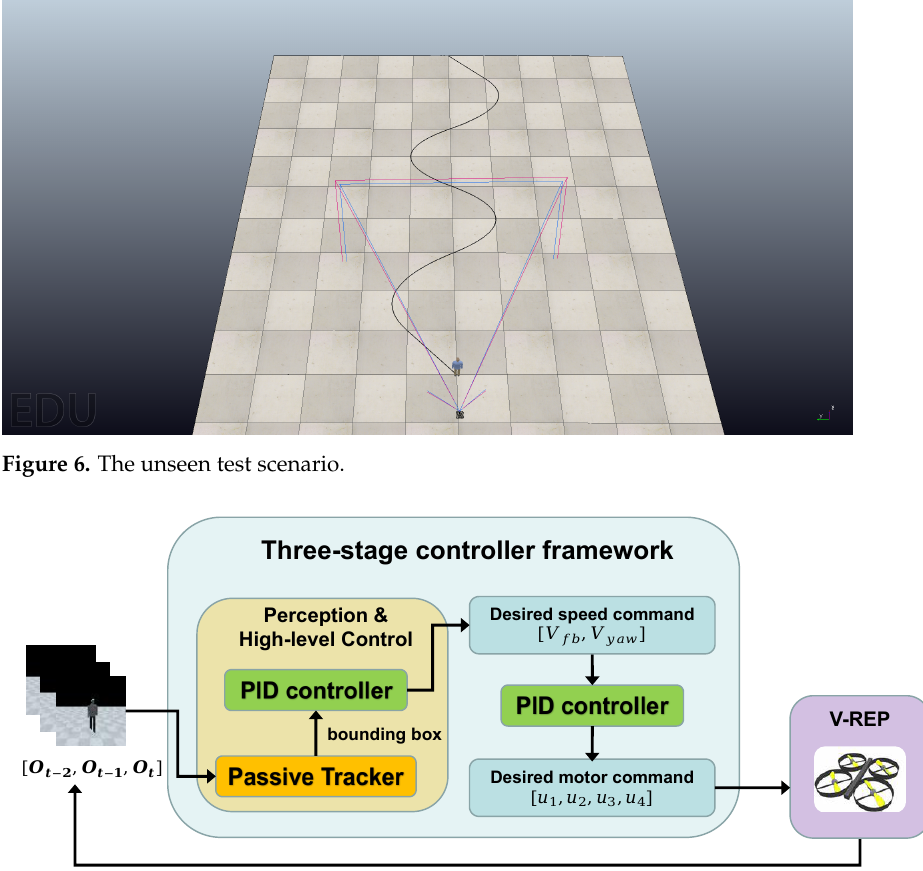
Figure 7. The control framework of our baseline